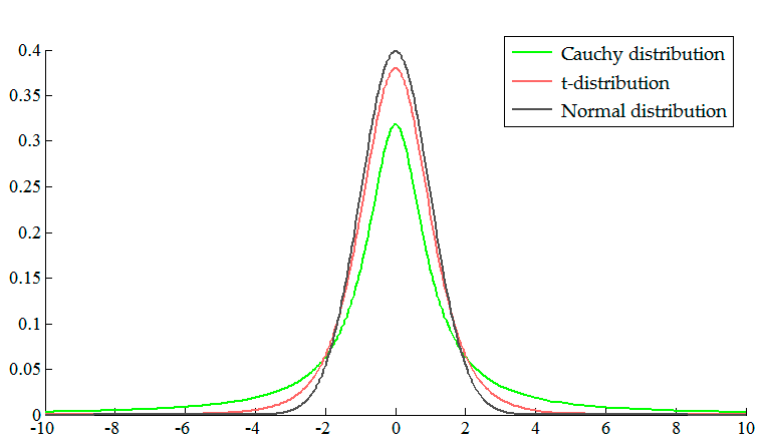
Figure 3. Probability density function curve of Cauchy distribution, t-distribution and Normal distribution.